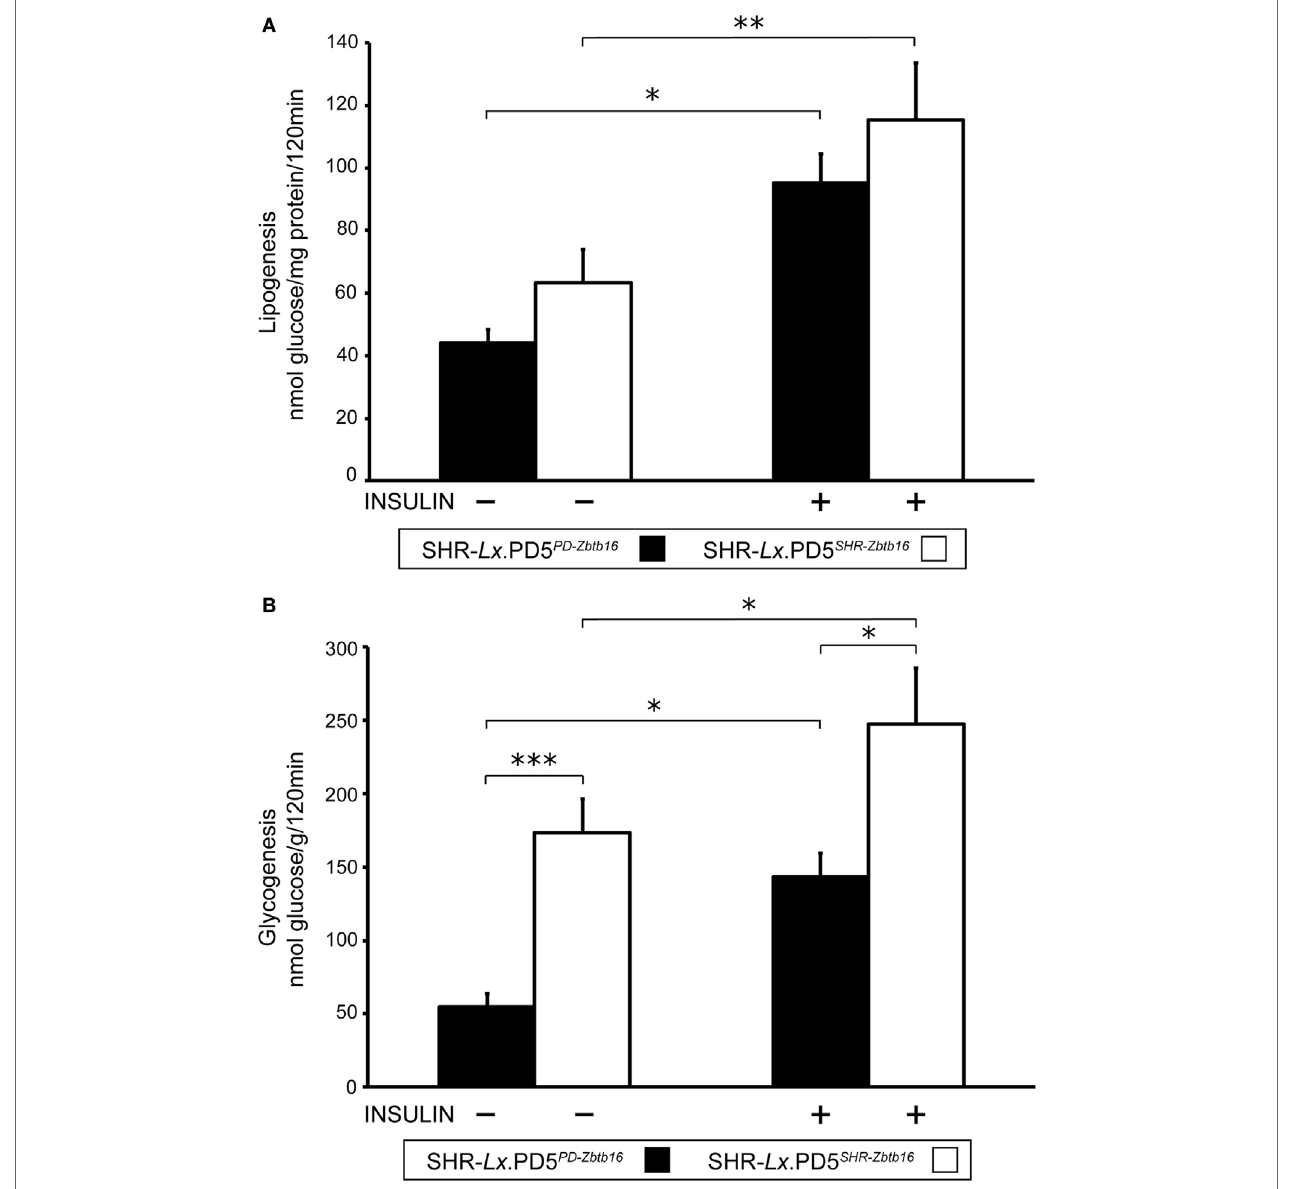
FigUre 3 | Insulin sensitivity of peripheral tissues in the SHR- Lx .PD5 PD- Zbtb16 and SHR- Lx .PD5 SHR- Zbtb16 male rats. Basal- and insulin-stimulated [U- 14 C] glucose incorporation into total lipids of epididymal (visceral) adipose tissue [lipogenesis (a) ] and into glycogen of the diaphragm [glycogenesis (B) ] in the SHR- Lx .PD5 PD- Zbtb16 (full bars) and SHR- Lx .PD5 SHR- Zbtb16 (open bars) are shown. Data are expressed as mean ± SEM ( n = 8 individual rats/group). Adjusted statistical significance levels using the unpaired t -test are indicated as * P < 0.05; ** P < 0.01; and *** P <